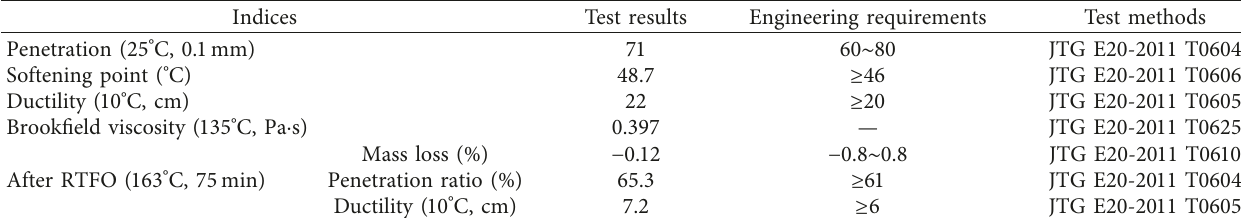
Table 2: Properties indices of 70-A matrix asphalt